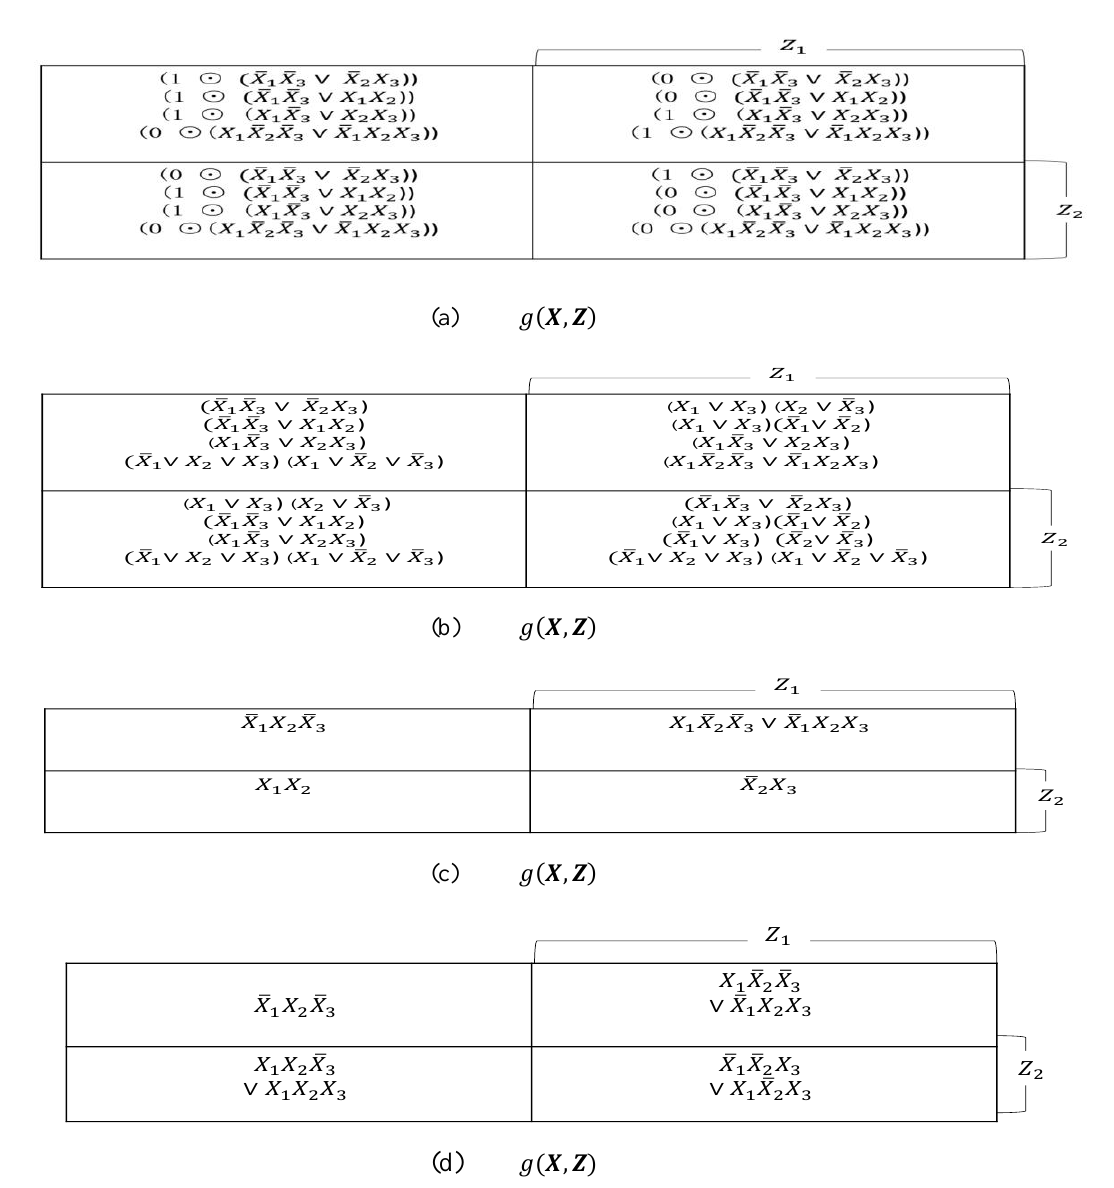
Fig. 9. Gradual development of the natural map for 𝑔(𝑿, 𝒁) obtained by suppressing 𝒀 from ℎ(𝑿, 𝒀, 𝒁) in Fig.